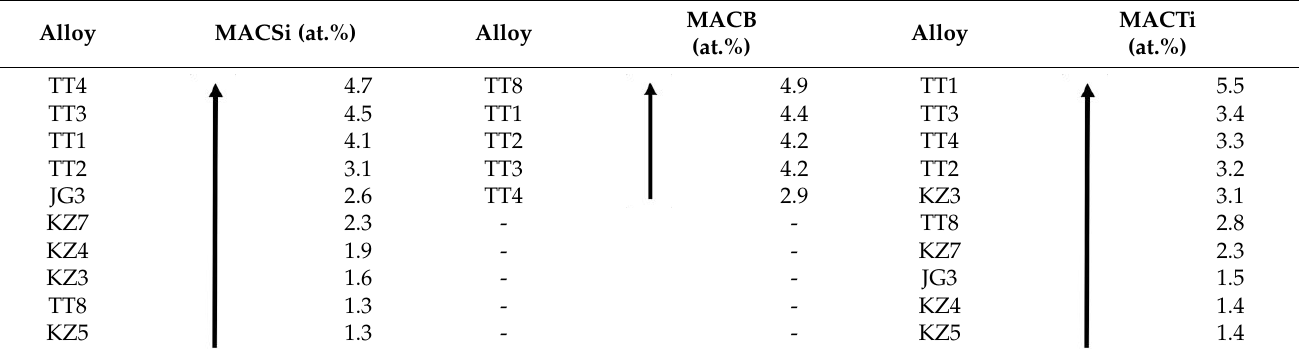
Table 7. Comparison of the macrosegregation (MACX) of X = B, Si or Ti in the B containing alloys of this work and their basis/reference alloys KZ3, KZ4, KZ5, KZ7 [16] and JG3 [17] (see Appendix A). Large button ingots (0.6 kg) of all alloys were prepared using arc melting. Note that the table includes data for the alloy TT1 (Nb-24Ti-18Si-8B [12]) and its basis alloy KZ3 (Nb-24Ti-18Si